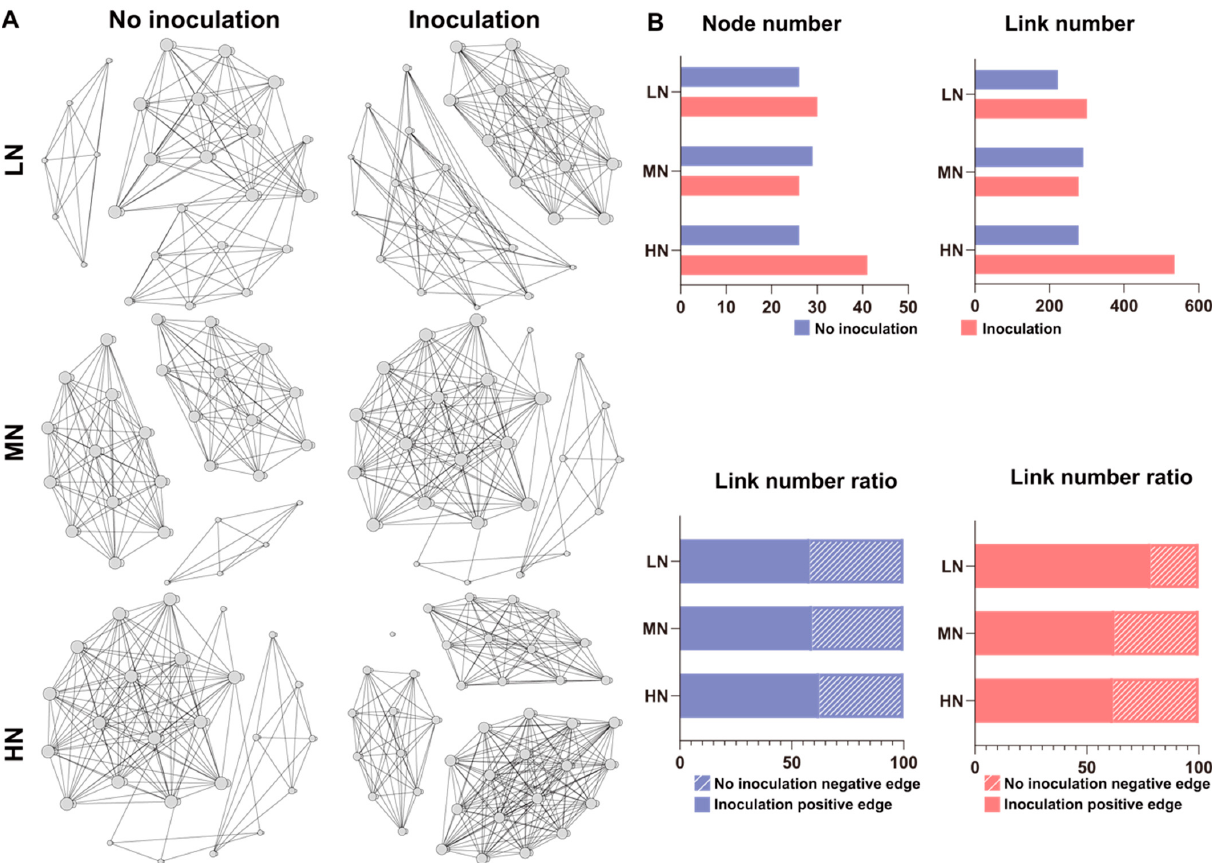
Figure 10. Co-occurrence network of biology–biology, representing the fungal interactions in the rhizosphere at different nitrogen levels ( A ). The topological characterizations include the node number, link number and link number ratio (positive link versus negative link) ( B ). The connections are Spearman correlations with significance ( p < 0.05) and high significance (0.6 < |r| < 1).